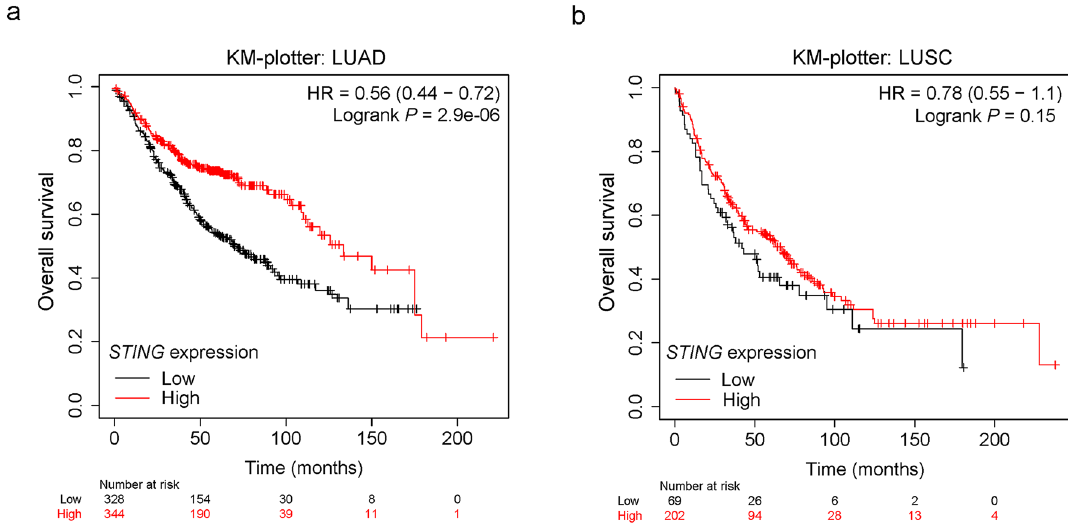
Figure 2. Downregulation of STING expression is correlated with unfavorable outcomes in LUAD but not LUSC. ( a, b) The relationship between STING expression and OS in LUAD ( a ) and LUSC ( b ) was investigated using the KM-plotter database. KM-plotter, Kaplan–Meier